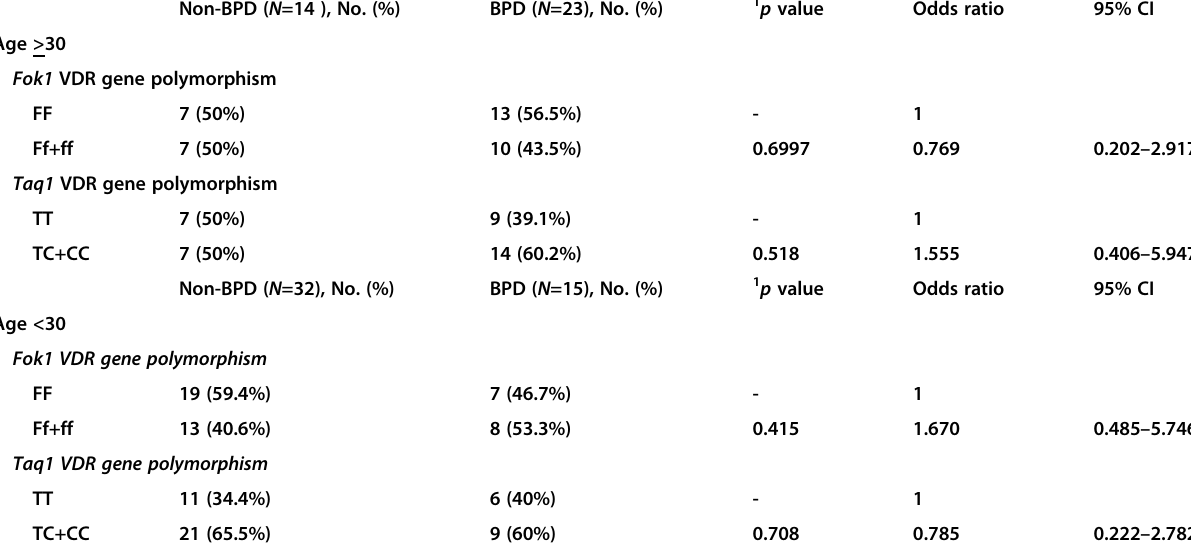
Table 3 Genotypic distribution of Taq 1 and Fok 1 VDR polymorphisms among different age groups Non-BPD ( N =14 ), No. (%)